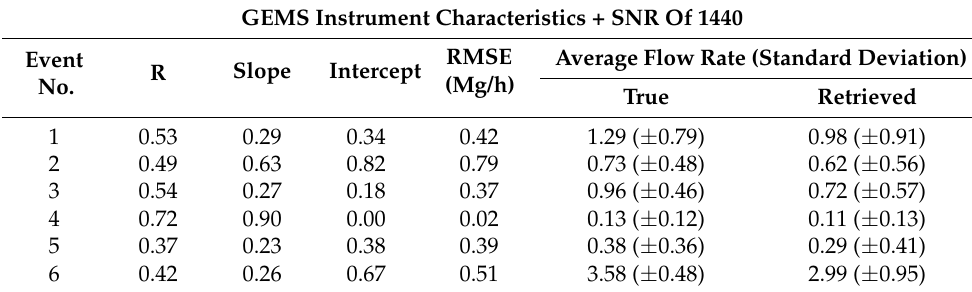
Table 4. Statistical analysis of the true SO 2 flow rates and those calculated under the presence of the SO 2 retrieval error from the GEMS synthetic radiances and no uncertainty in wind data.